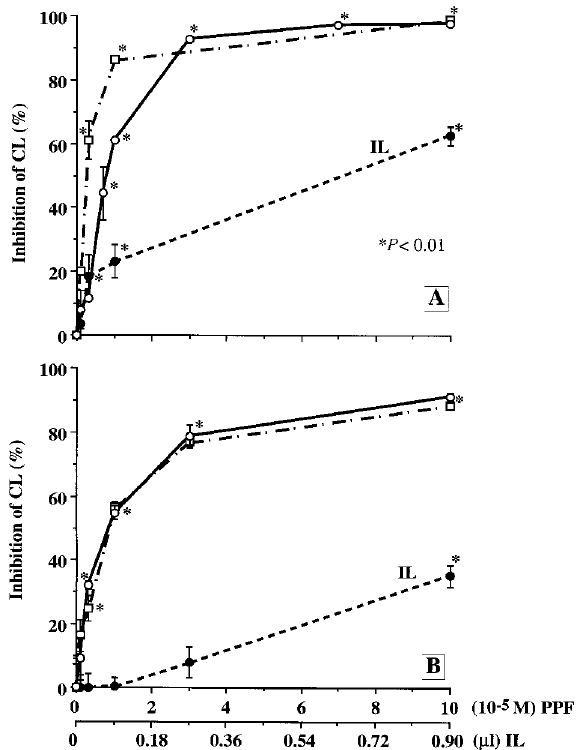
FIG. 4. Inhibition (±SD) of the CL of the H 2 O 2 /peroxidase system (above: H 2 O 2 /HRP; below: H 2 O 2 /MPO) by pure PPF dissolved in carbitol ( s